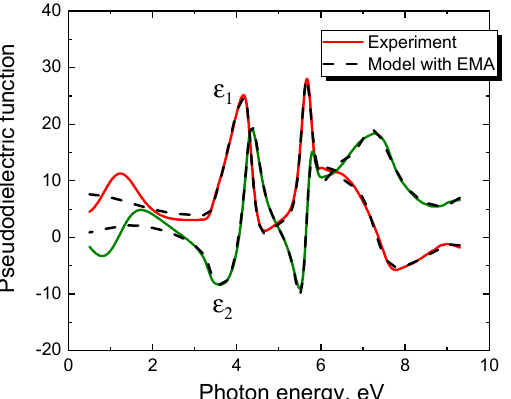
Figure 4. Dependence of the pseudodielectric function ( ε 1 is its real part, ε 2 is its imaginary part) on the photon energy of a 3C-SiC/Si(111) sample grown by the method of substitution of atoms on a Si(111) substrate for 15 min at T = 1280 °C and CO pressure p CO = 100 Pa (solid line). The dashed line is the best theoretical dependence for this spectrum, obtained within a complex two-layer model using EMA.